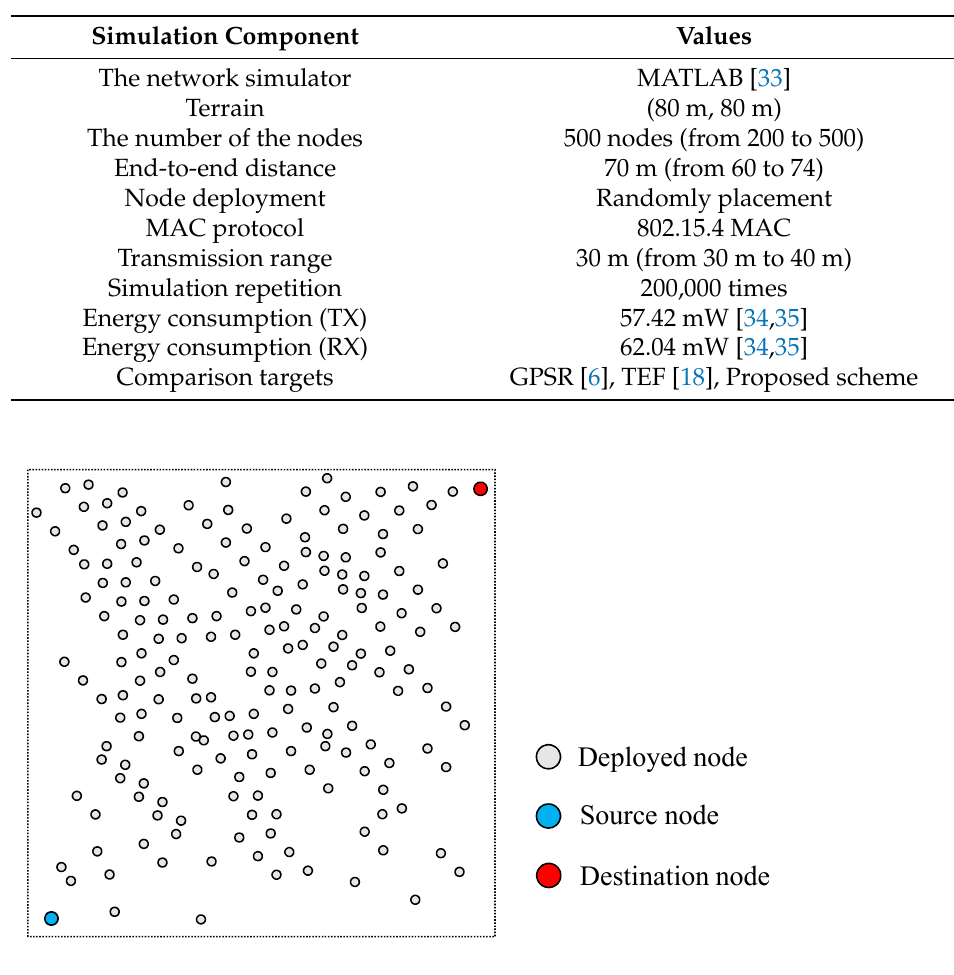
Figure 6. Example among random deployment of nodes in